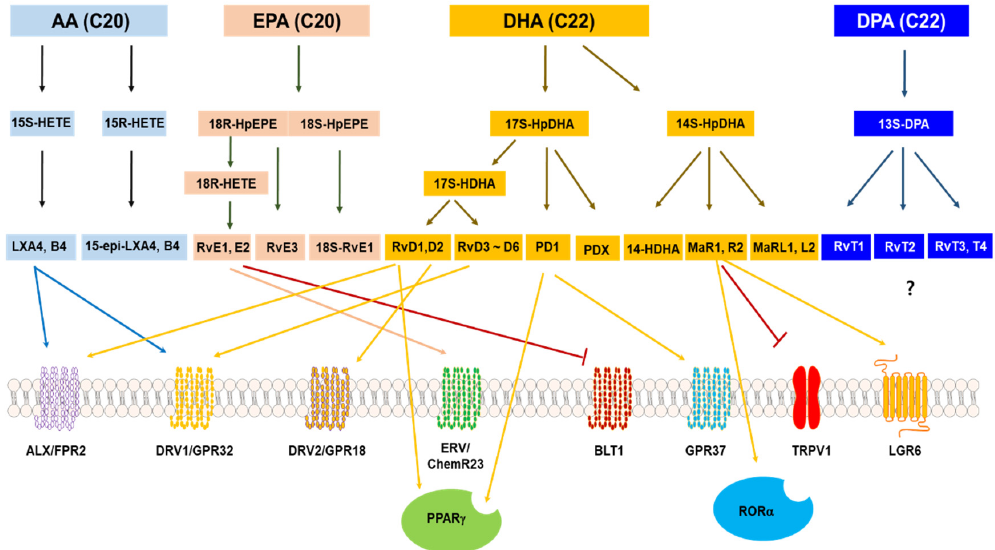
Figure 3. SPMS and their receptors. Arrow heads of lines represent activation of receptors, and bar heads of lines indicate the inhibition of receptors? Means that no receptors are reported for each SPM (modified from Pirault et al. [68] ).